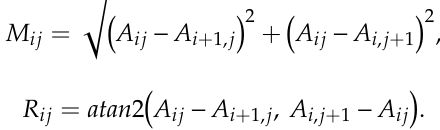
Figure 2. Structure from motion (SfM) workflow.